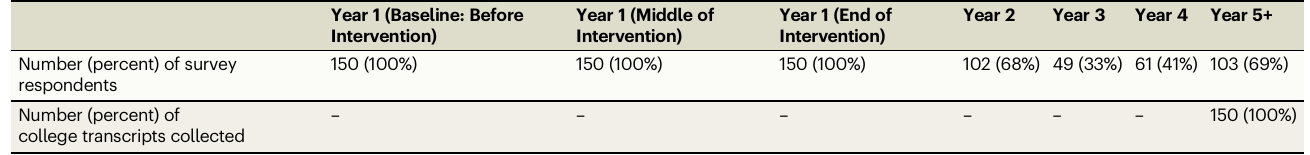
Table 2 | Number of participants across timepoints for continuous variables Year 1 (Baseline: Before